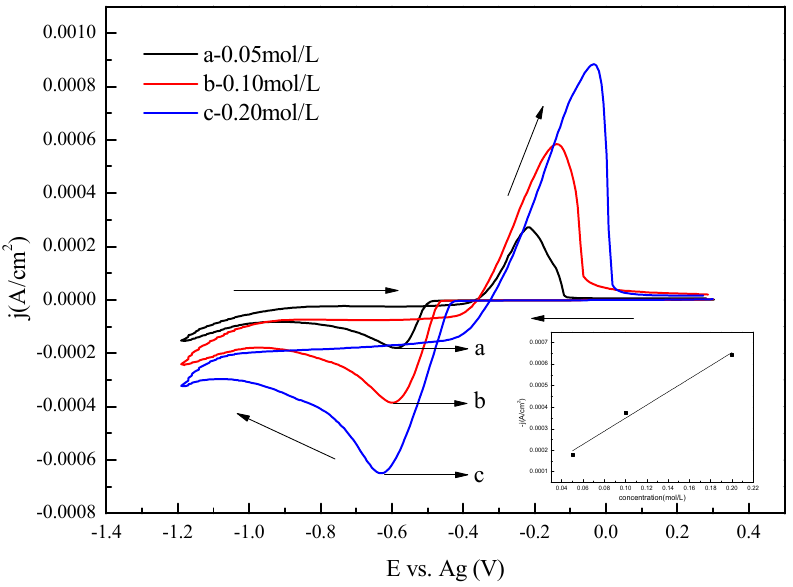
Figure 3. CVs with different Sn(II) concentration in ChCl–urea at 323 K and 100 mV/s (the bottom right corner of the figure is the relationship between the peak current density and the concentration of SnCl 2 ).